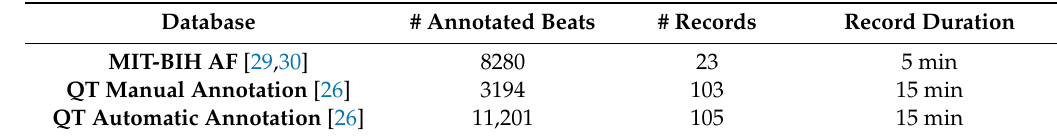
Table 1. Databases used for evaluation and